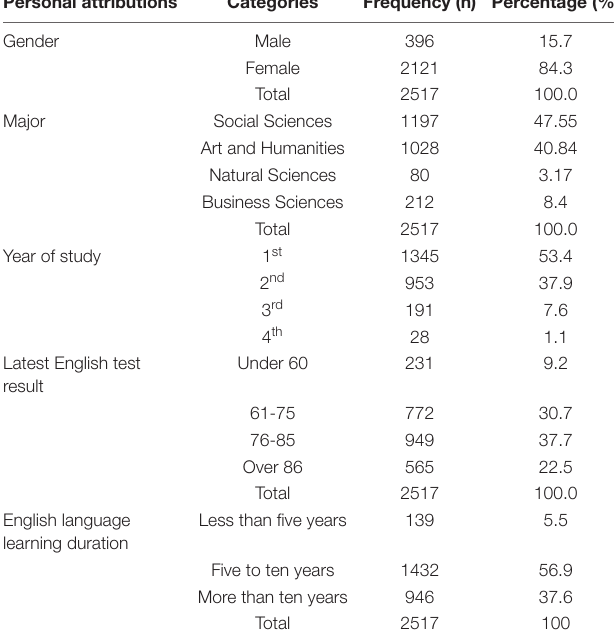
TABLE 2 | Demographic profile of